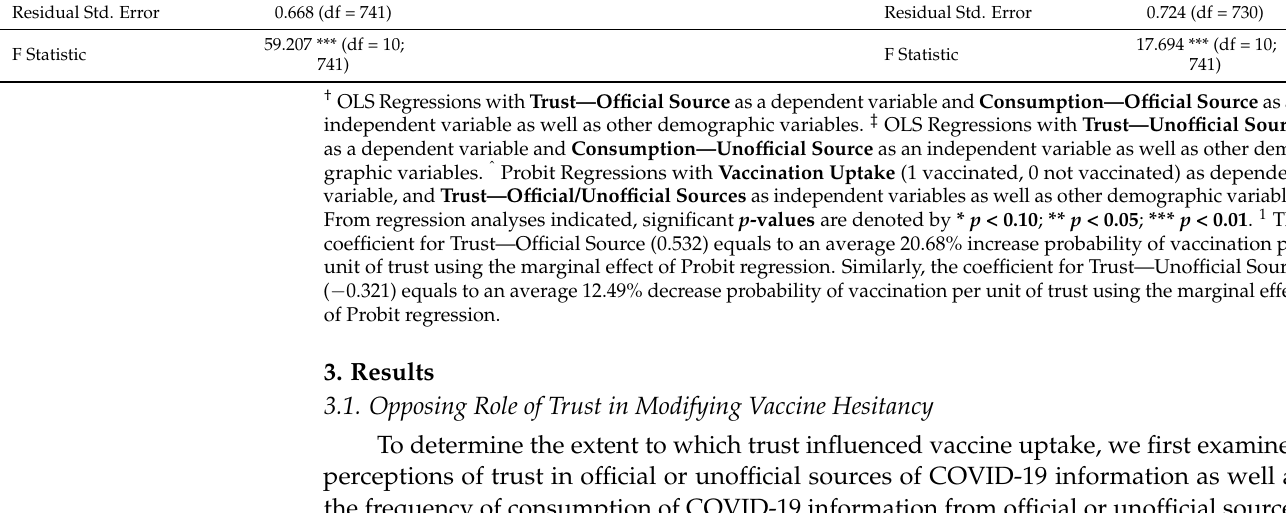
variable, and Trust—Official/Unofficial Sources as independent variables as well as other demographic variables. From regression analyses indicated, significant p -values are denoted by * p < 0.10 ; ** p < 0.05 ; *** p < 0.01 . 1 The coefficient for Trust—Official Source (0.532) equals to an average 20.68% increase probability of vaccination per unit of trust using the marginal effect of Probit regression. Similarly, the coefficient for Trust—Unofficial